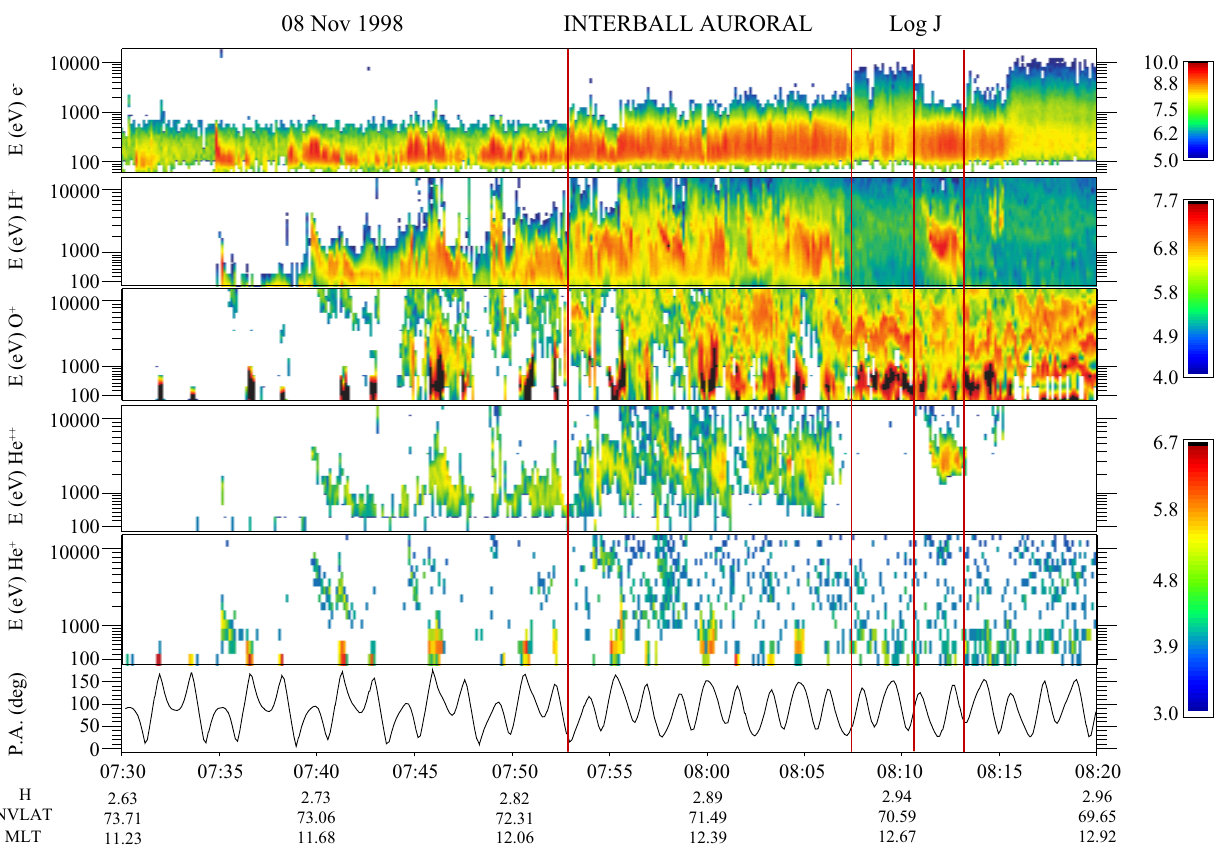
Fig. 2. Interball Auroral observations on 8 November 1998 between 07:30 to 08:20 UT. From top to bottom: the energy time spectrograms for electrons, H + , O + , He ++ , He + . The fluxes are color coded. The bottom panel indicates the pitch-angle variations as a function of time. The vertical line delimitates the different regions discussed in the